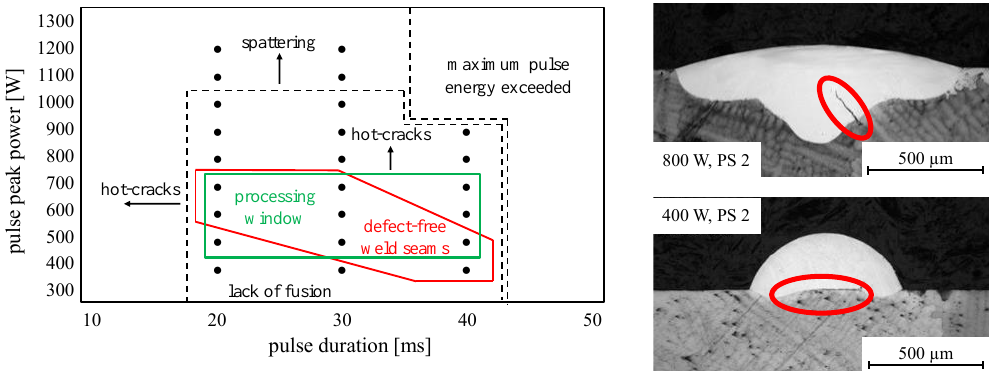
Figure 8. Processing window and its limitations ( left ) and typical welding defects ( right ): hot-crack (top panel) and lack of fusion (bottom panel). The wire-feeding rate was always 2 mm/s and the pulse frequency 14 Hz.